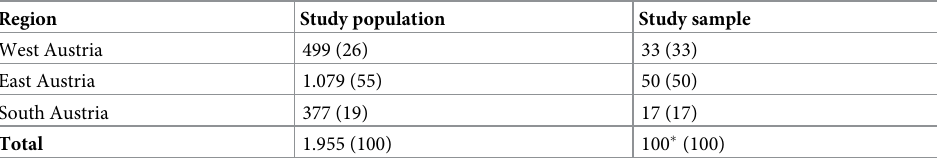
Table 1. Analysis of non-response regarding location for Austrian veterinarians (counts (percentage)).